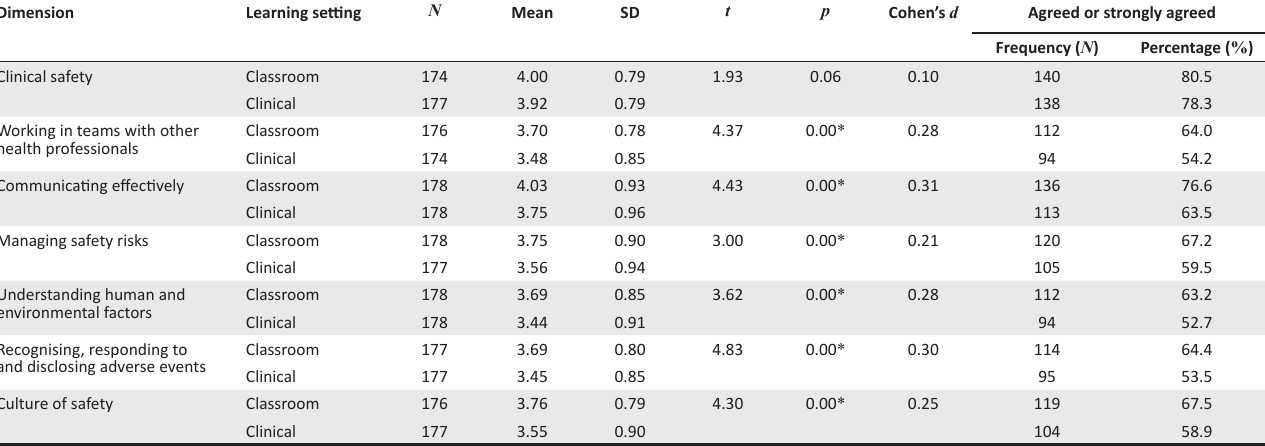
TABLE 2: Self-reported patient safety competence in different learning settings. Dimension